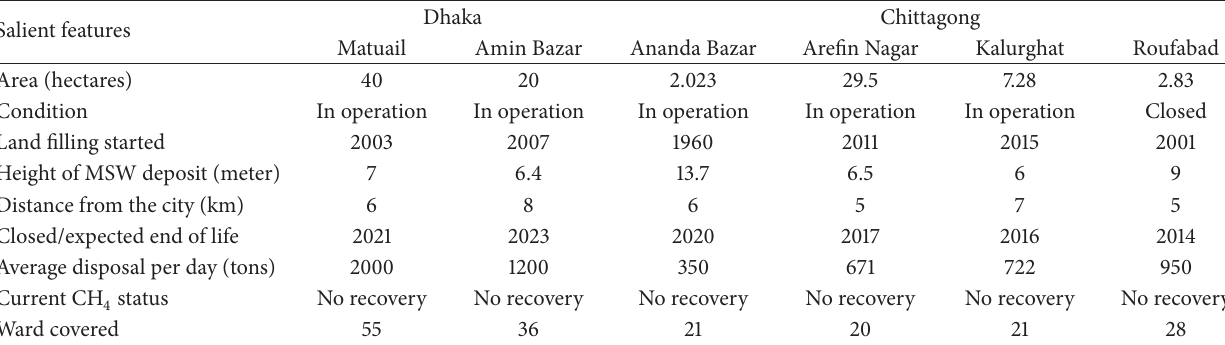
Table 2: MSW disposal site and their salient features in Dhaka and Chittagong city. Dhaka Salient features